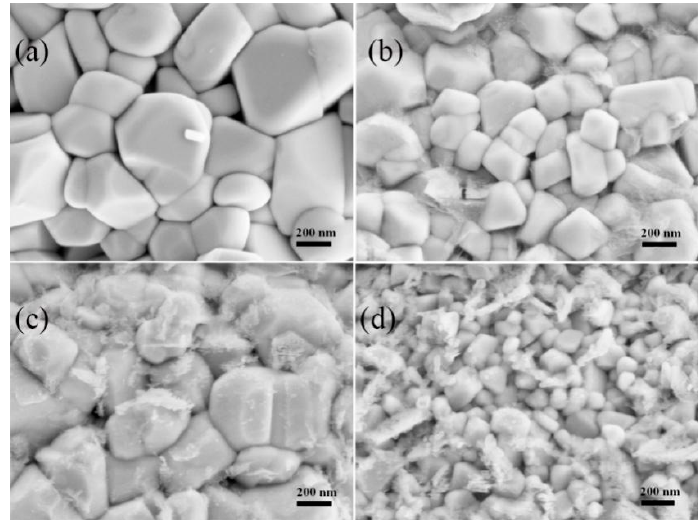
Figure 2. SEM images of the as-prepared samples ( a ) NCA, ( b ) NCA-0.25, ( c ) NCA-0.5, ( d ) NCA-2.